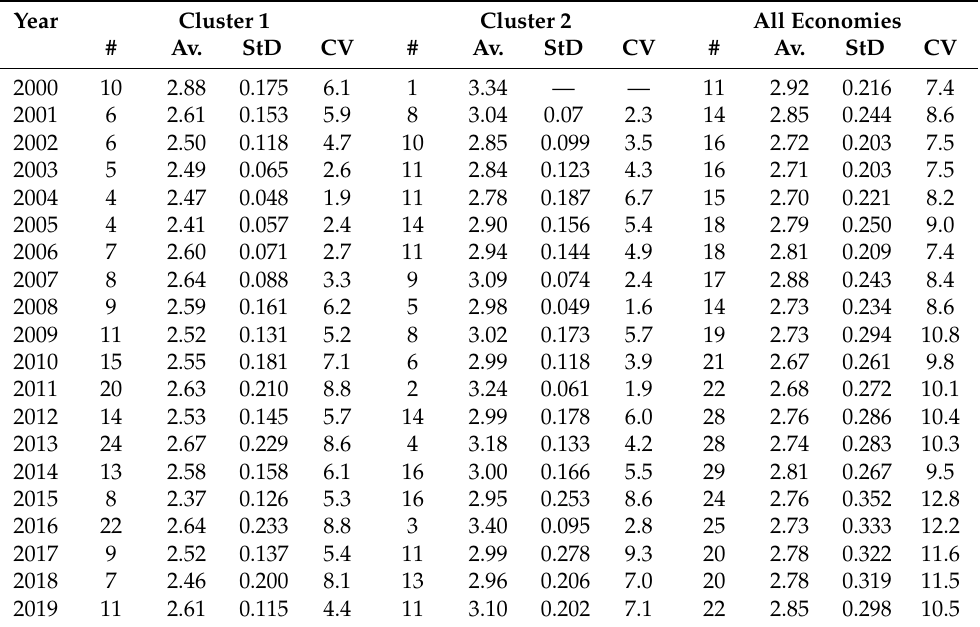
Table 3. Characterization of the clusters in Table